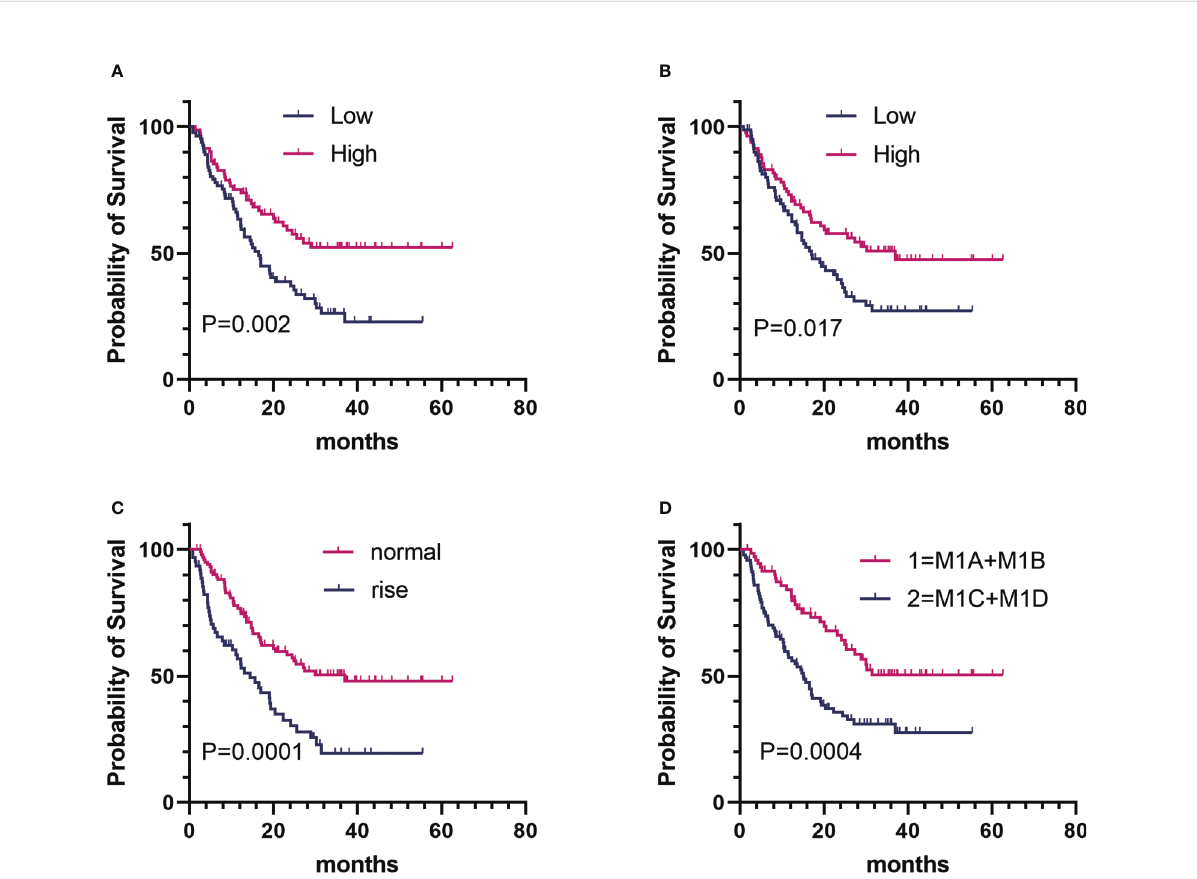
FIGURE 1 Kaplan – Meier estimates of overall survival (OS) of patients with metastatic melanoma in different groups. (A) Baseline FT3:OS curve of patients in the high group (n = 82) versus the low group (n = 83). (B) baseline A-TPO : OS curve of patients in the high group (n = 83) versus the low group (n = 82). (C) LDH level:OS curve of patients in the normal group (n = 103) versus the rise group (n = 62). (D) M stage:OS curve of patients in group 1 (n = 72) versus group 2 (n =